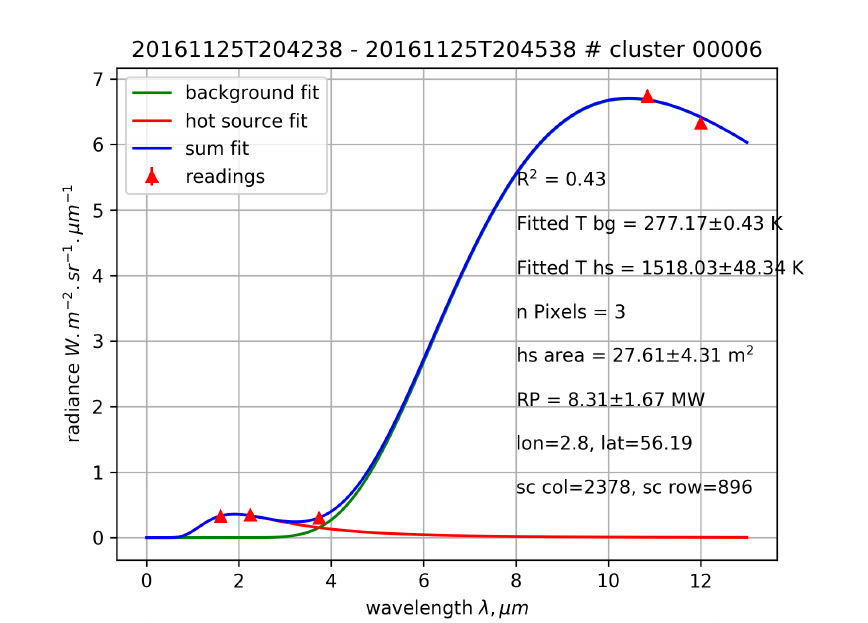
Figure 7. An example of the temperature and area retrieval by dual Planck curve fitting. More examples can be found in the Supplementary